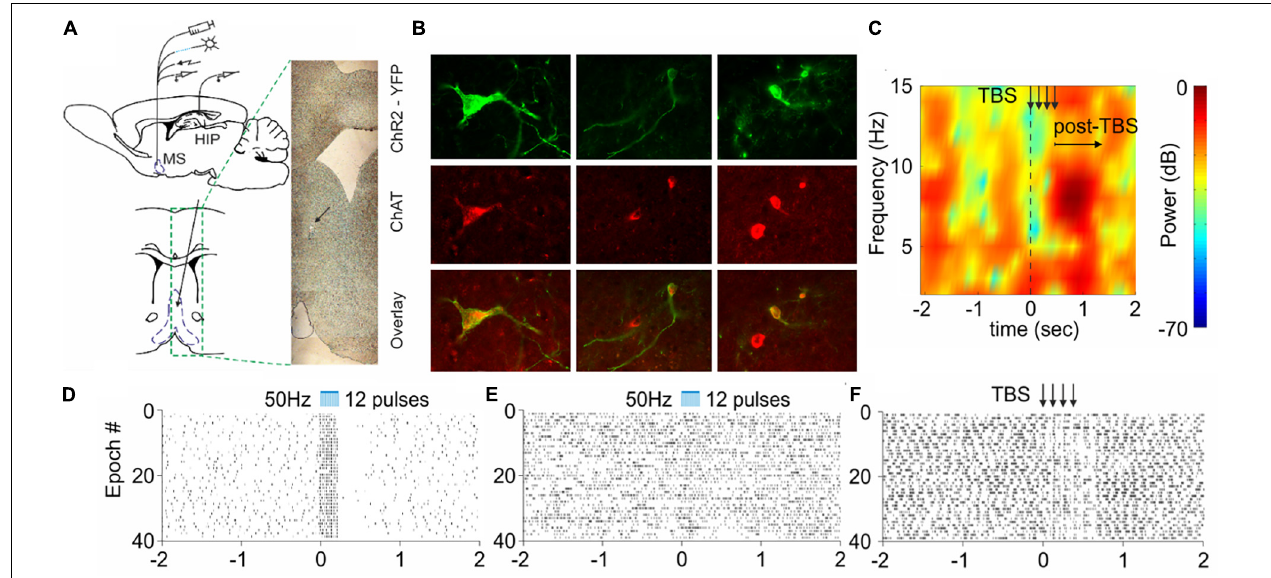
FIGURE 1 | Selective cholinergic and non-selective septal stimulation effect on hippocampal activity. (A) Atlas schematic of experimental setup investigating the effect of septo-hippocampal stimulation (MS, medial septum; HIP, hippocampus). The histological section indicates the tip of the optic fiber and electrode. (B) Colocalization of ChAT staining and ChR2-YFP expression in the medial septum of ChAT:Cre rats. (C) Sample color-coded power spectrogram recorded in dorsal CA1 after electrical theta-burst stimulation (TBS) of the medial septum. (D) Raster plot from 40 repetitions of optically evoked time-locked responses of ChAT-positive cell in the medial septum. Time 0 indicates the delivery of the first train of the stimulation protocol (the scale of X-axis is in seconds). (E) Raster plots from of optically evoked responses from hippocampal neuron after selective optogenetic stimulation of cholinergic septal projections. (F) Raster plot of hippocampal cell spikes after non-selective TBS of the medial septum. The arrows show the delivery time of four trains (adapted from Mamad et al.,